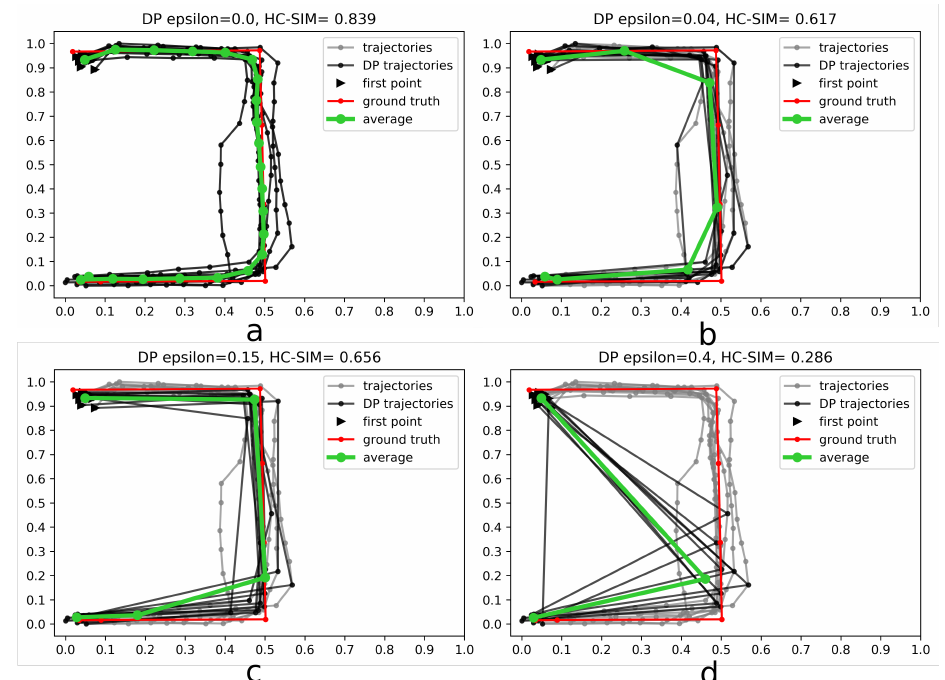
Figure A5. Algorithm applied to sample 95 with varying (cid:101) . ( a ) (cid:101) = 0.0, ( b ) (cid:101) = 0.04, ( c ) (cid:101) = 0.15, ( d ) (cid:101) = 0.4.